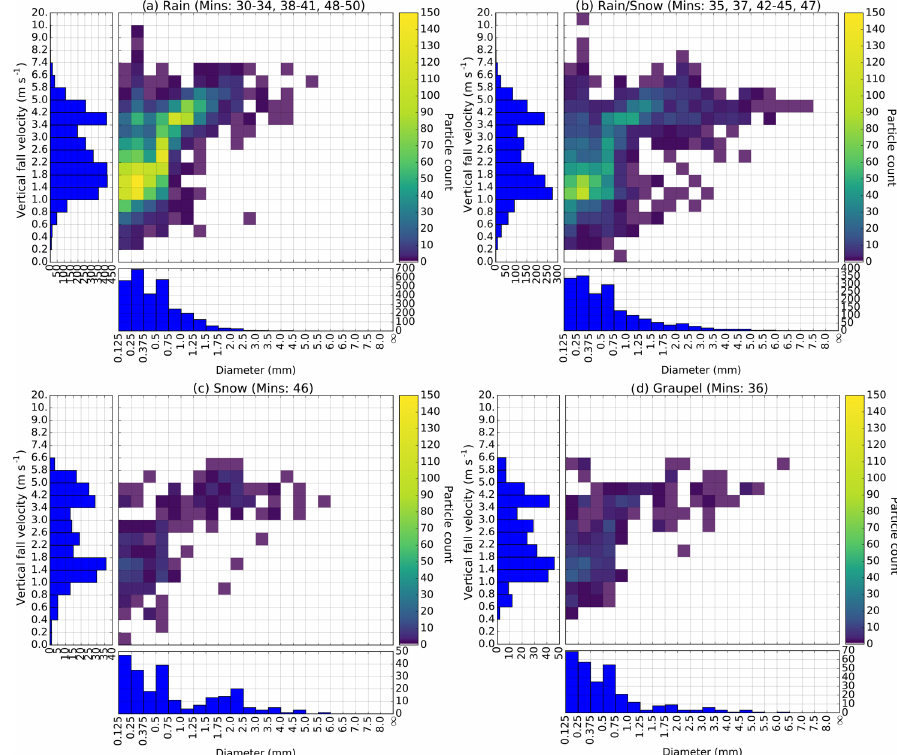
Figure 14. Accumulated particle information for each hydrometeor class period described in Fig. 13. The centre grid shows particle counts binned by size and fall velocity. The y -axis histogram shows particle velocity distribution (DVD) and the x -axis histogram shows particle size distribution (DSD) for the time period described. The periods are as follows: (a) rain (12min), (b) rain/snow (7min), (c) snow (1min), and (d) graupel (1min). The colour scale is identical in all plots despite the different time accumulations in order to highlight the rare